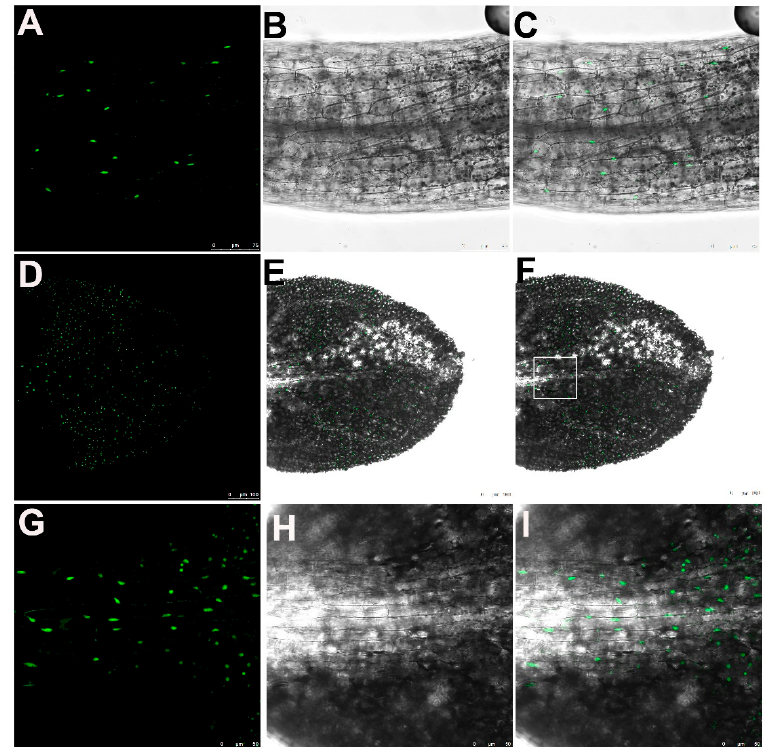
Figure 3. Expression pattern and subcellular localization of IBR5. ( A – C ) Representative images of IBR5 expressed and localized in the nucleus of petiole cells. Bars, 75 µm. ( D – F ) Representative images of IBR5 expressed and localized in the nucleus of epidermal cells of 2-day-old leaves. Bars, 100 µm. ( G – I ) Representative images of IBR5 expressed and localized in the nucleus in the boxed region in the figure ( F ). Bars, 100 µm.